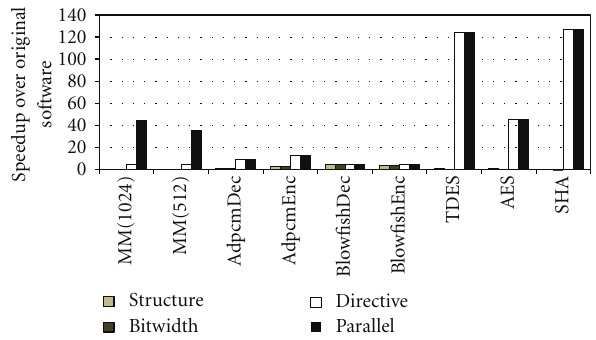
Figure 7: Speedup over original software for each kernel. Directive denotes the pipelining and loop optimization